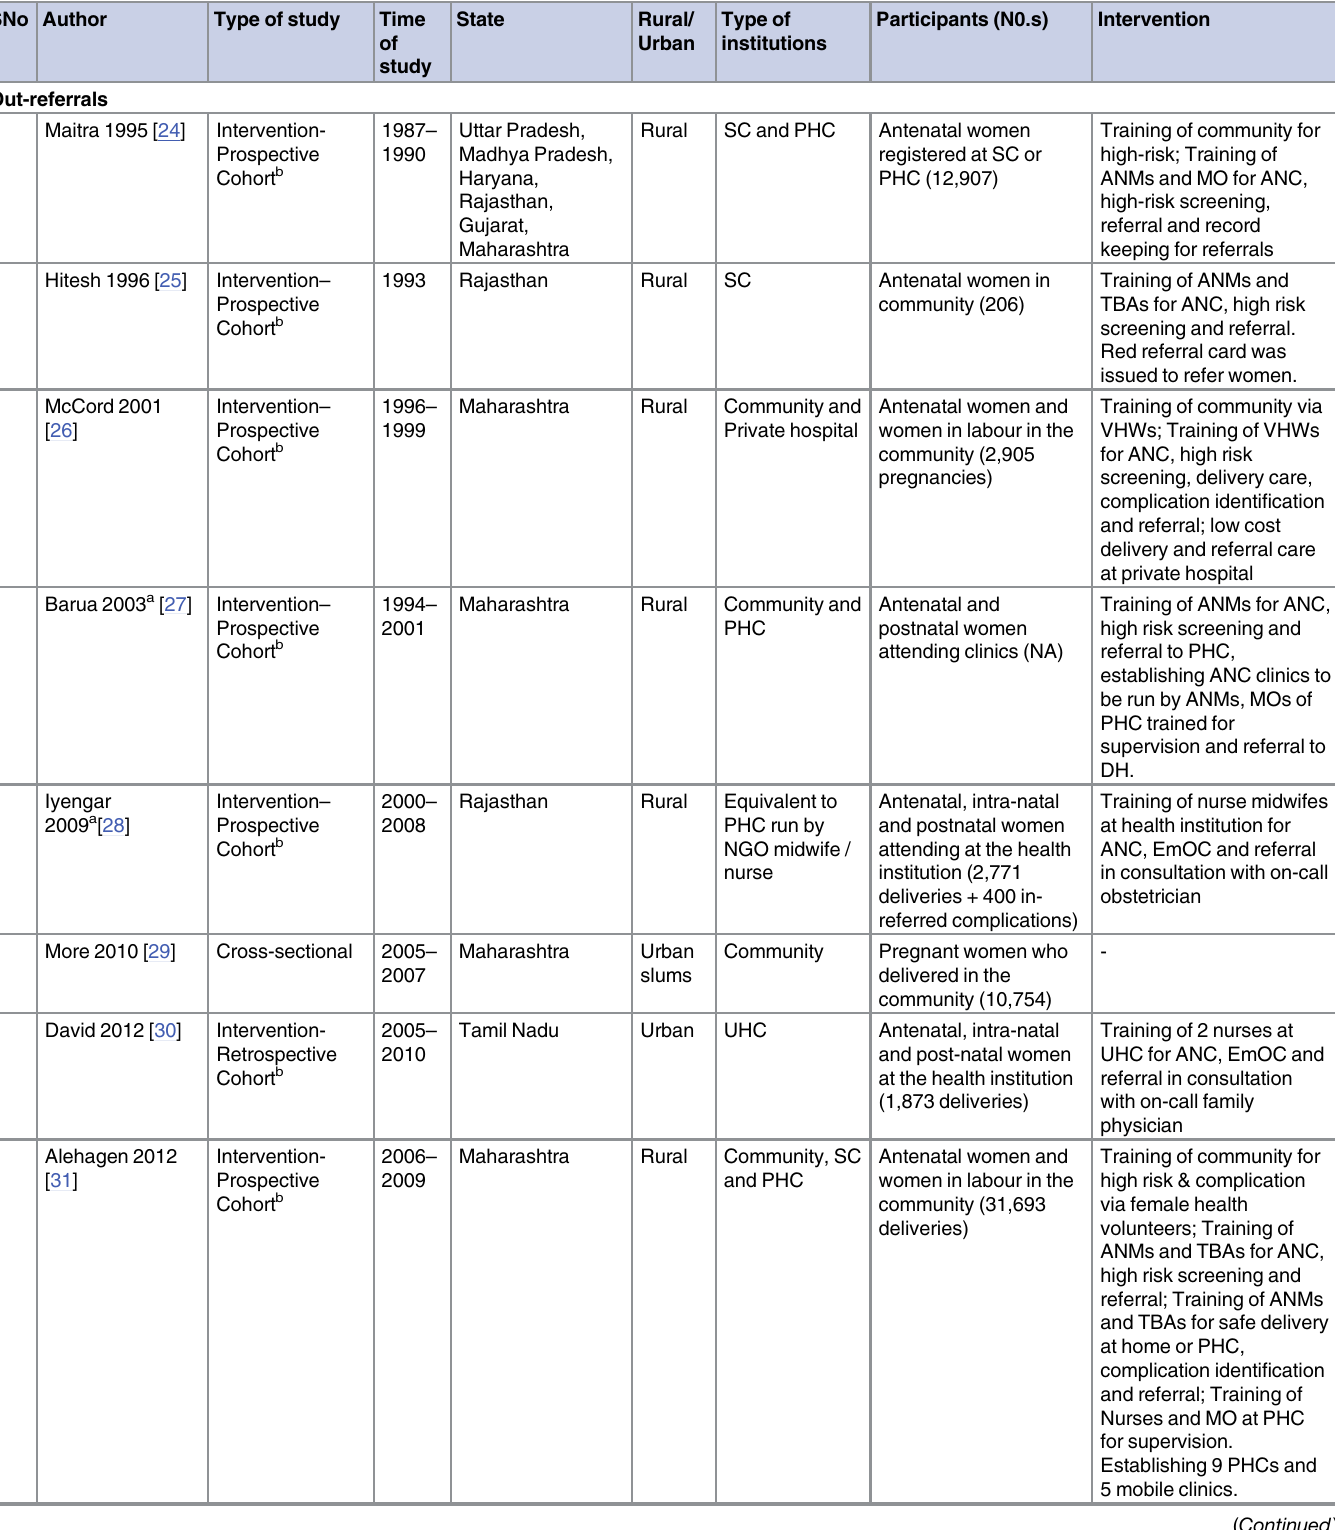
Table 1. Characteristics of studies included in the